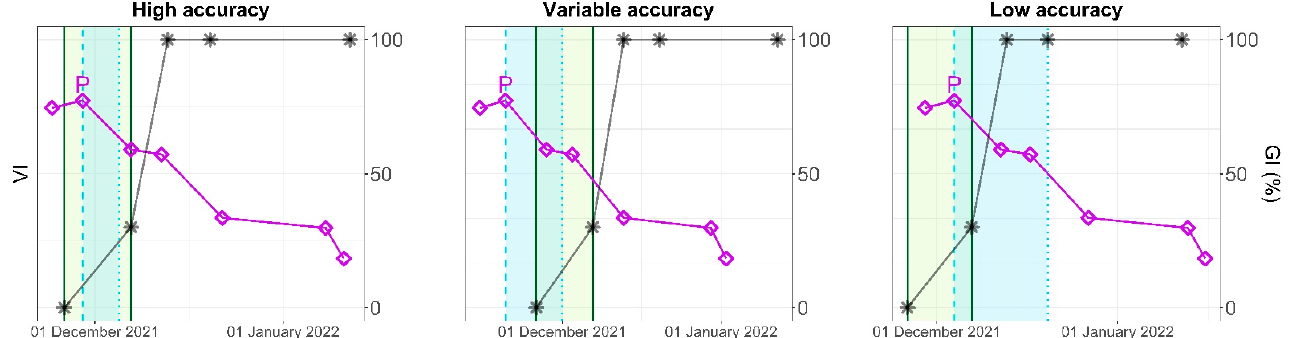
Figure 1. Graphical assessment of the accuracy of satellite-based detection of the start of frost events. The VI dynamics is represented by the purple line and its peak is indicated by the letter ‘P’,; the satellite-based time frame is represented by the light-blue box, while the frost time window measured from the ground is represented by the light green box. The GI is repre-sented with grey stars